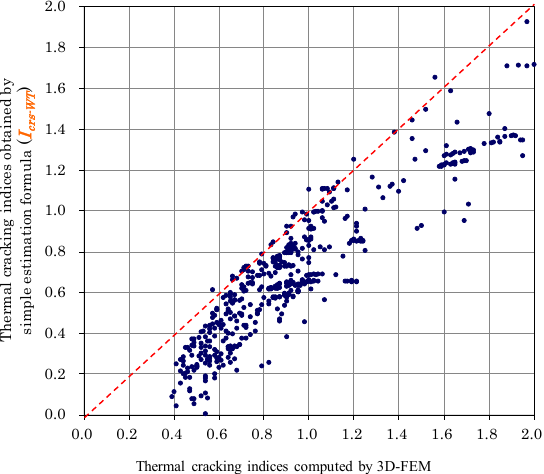
Figure 8. Thermal cracking indexes obtained by the simple estimation formula plotted against results of